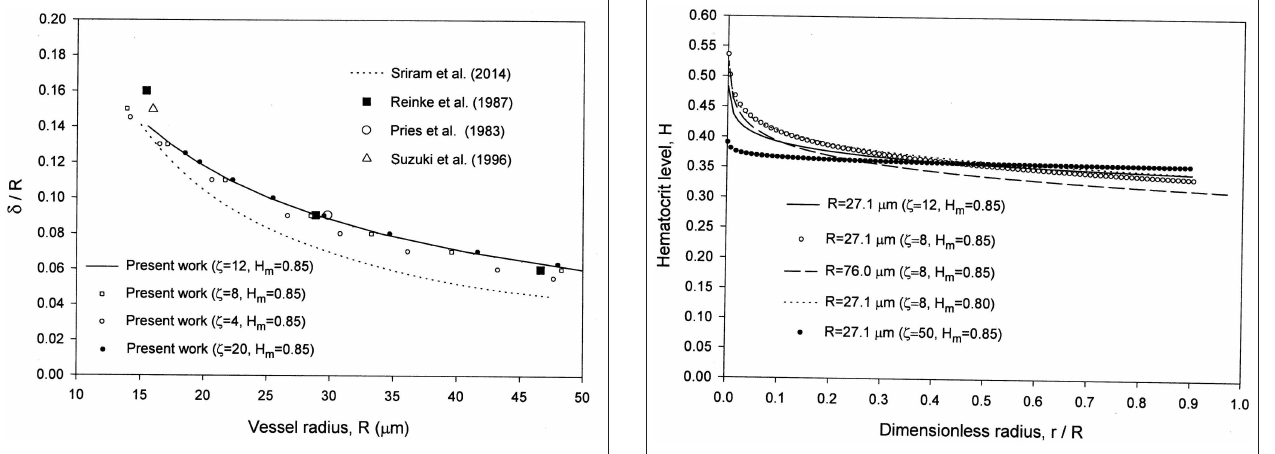
FIGURE 3 | Present model results for the hematocrit level in the core region for H D = 0.335 and two values of R = 27.1 and 76.0 µ m.